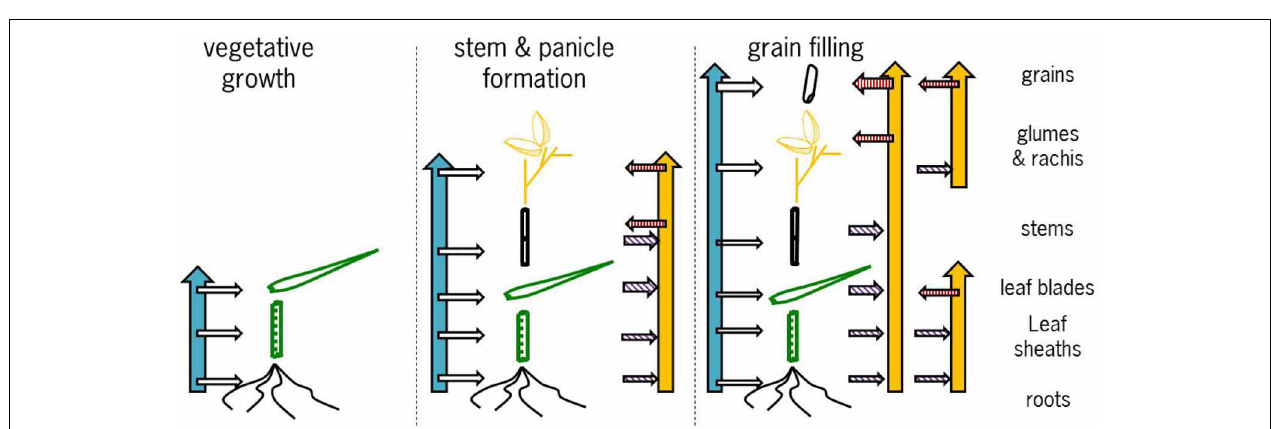
FIGURE 7 | Graphical representation of the proposed conceptual model of allocation and re-translocation of zinc during the subsequent stages of cereal development. The blue vertical and the horizontal arrows to the left of each panel indicate uptake and direct allocation to individual tissues, while the yellow vertical arrows to the